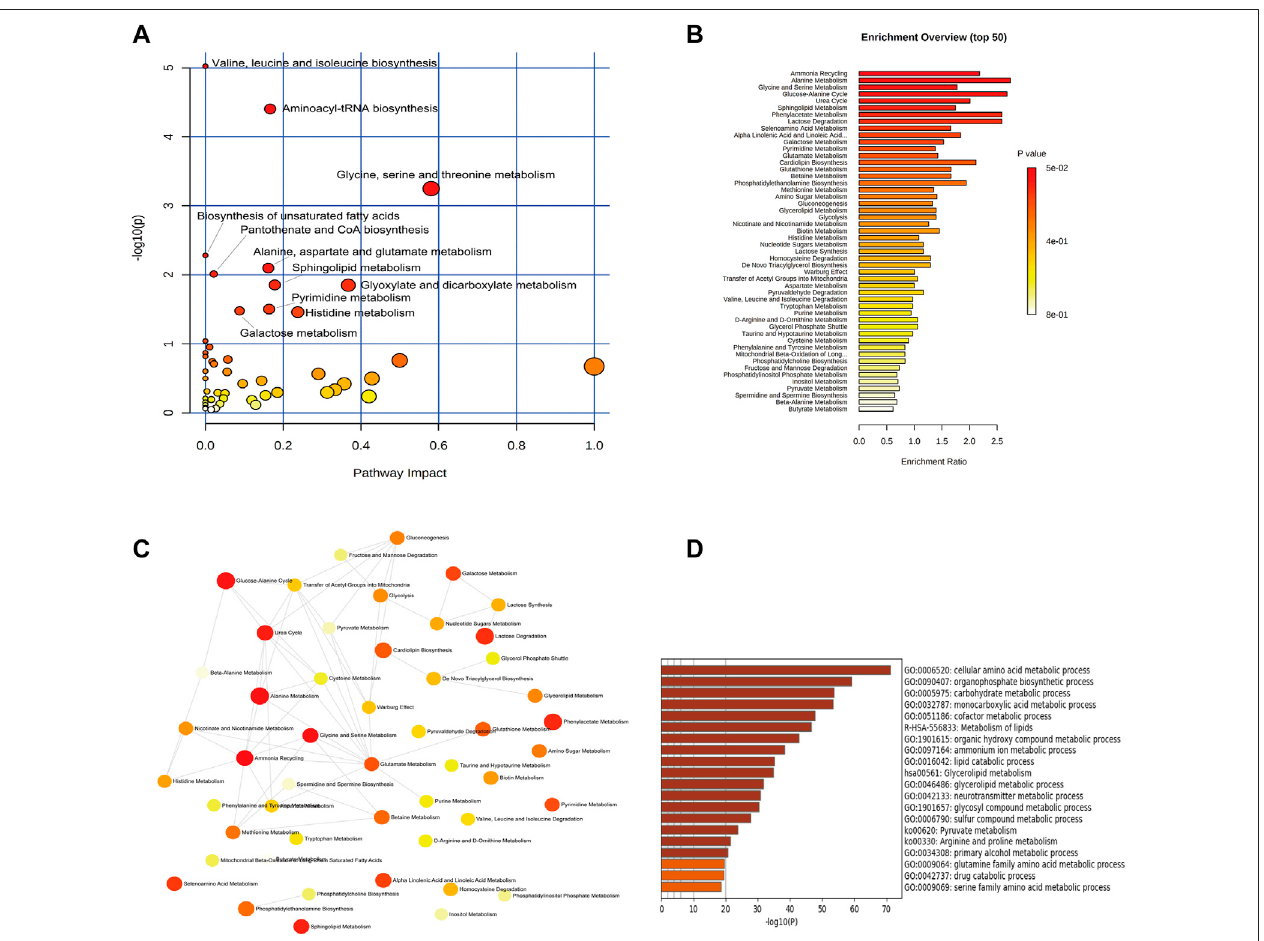
FIGURE 4 | Enrichment analysis of metabolic pathway and related regulatory enzymes. (A) Bubble plots of altered metabolic pathways. (B) Overview of biological function related to the differential endogenous metabolites. (C) Network map of pathways. (D) Regulatory enzyme GO enrichment analysis results.